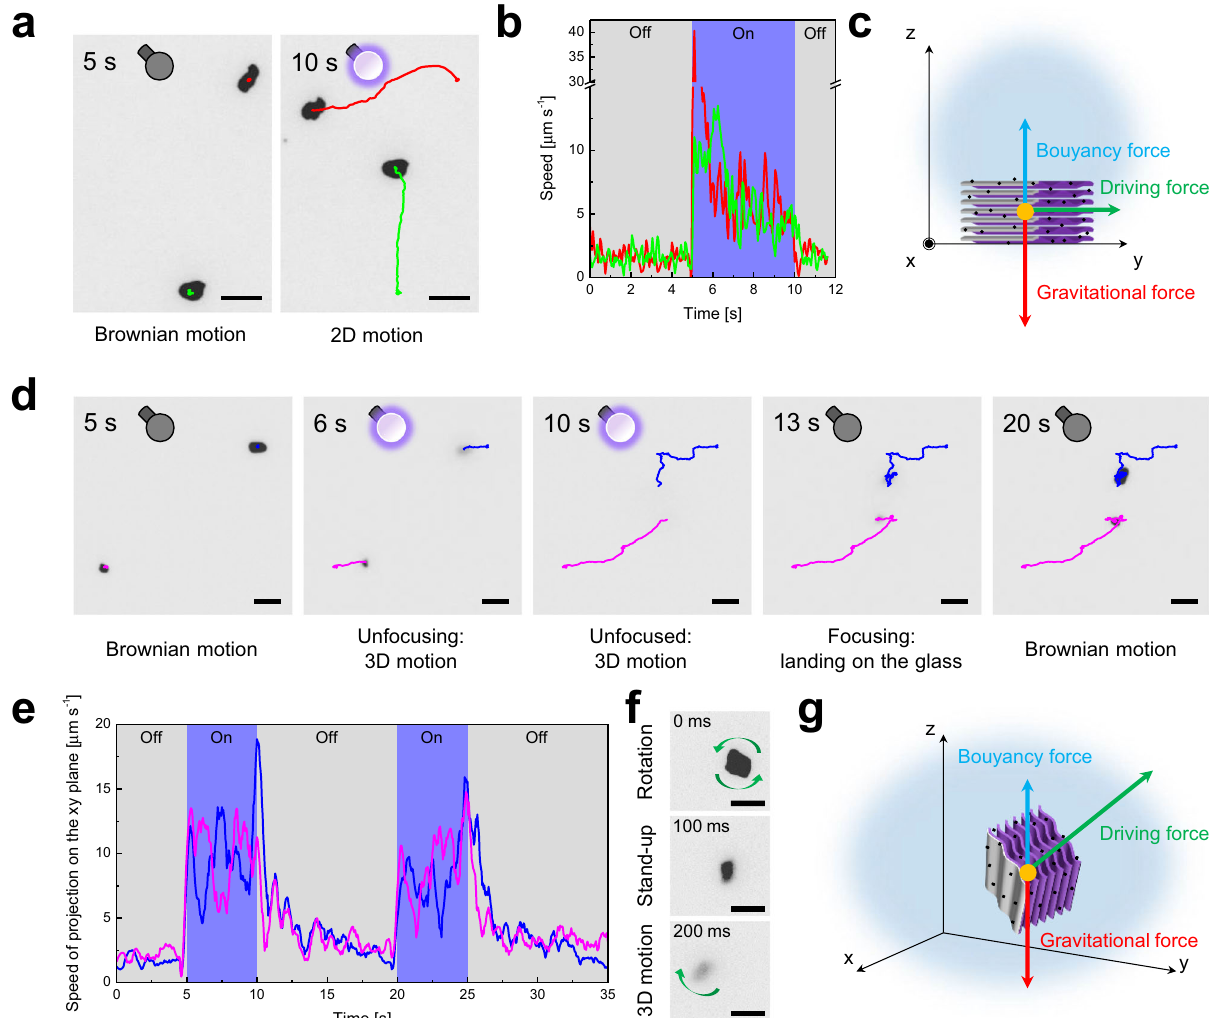
Fig. 3 Motion behavior of the MXene-derived γ -Fe 2 O 3 /Pt/TiO 2 microrobots in water under light irradiation. a Representative trajectories of the MXene-derived γ -Fe 2 O 3 /Pt/TiO 2 microrobots (thermal annealing condition: 0 min at 550 °C) moving on the xy plane (2D motion) in fuel-free water at pH 7 in the absence and presence of UV-light irradiation, b their corresponding instantaneous speed vs. time, and c force analysis. d Representative trajectories of the MXene-derived γ -Fe 2 O 3 /Pt/TiO 2 microrobots (thermal annealing condition: 0 min at 550 °C) moving in the xyz space (3D motion) in fuel-free water at pH 7 in the absence and presence of UV-light irradiation, e their corresponding instantaneous speed vs. time (trajectories and speeds are the projections of the actual microrobots ’ trajectories and speeds on the xy plane), f representative self-orientation by switching on the UV-light irradiation, and g force analysis. Scale bars are 10 μ